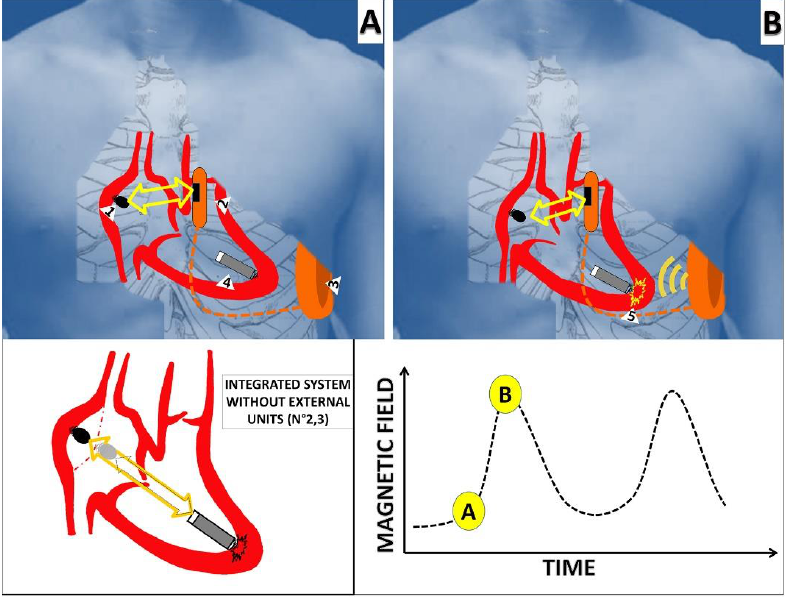
Figure 5. Heart activity monitoring with leadless devices. (1) A magnet placed in the right atrium, through which movements are revealed during the cardiac cycle using an external subcutaneous Hall effect sensor (HES) (2). The distance between magnet and HES decreases with atrial diastole ( A ), with a consequent increase in the magnetic field that reaches a maximum when the distance is minimal (( B ), atrial systole). Once atrial activity is revealed, the external device (4) can drive a ventricular leadless pacemaker (PM) (3). To avoid the necessity for external subcutaneous devices, an HES could be probably inserted directly in the leadless PM (5). Modified from “Infections of Cardiac Implantable Devices” by Diemberger, I.; Boriani, G., 2020, Infections of Cardiac Implantable